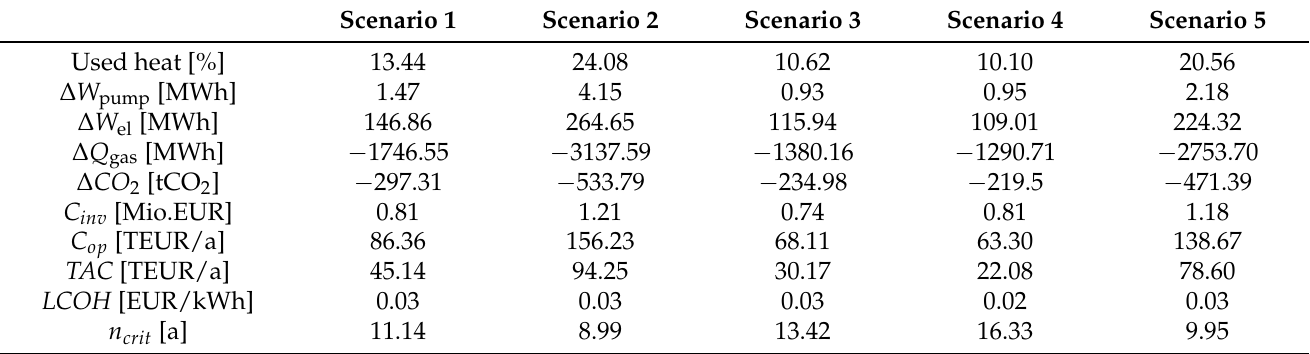
Table 8. Assessment results of all separation scenarios of the generic district heating